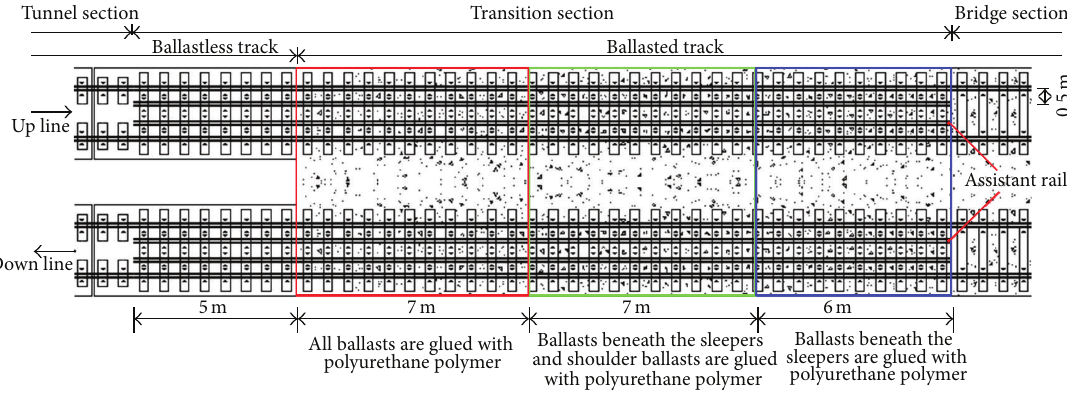
Figure 2: A schematic layout of the transition zone.